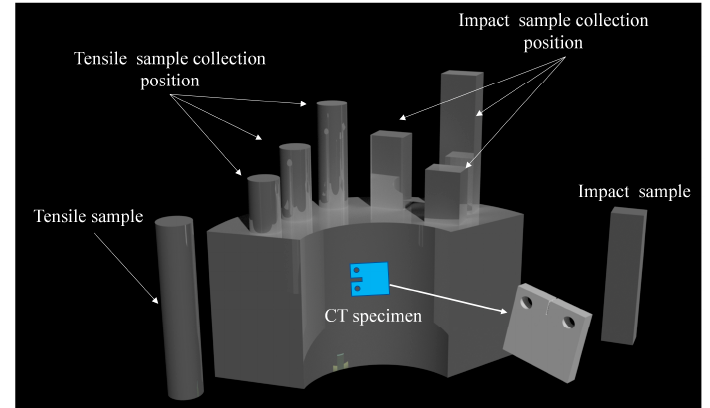
Figure 1. Schematic of specimen preparation from the casing coupling.